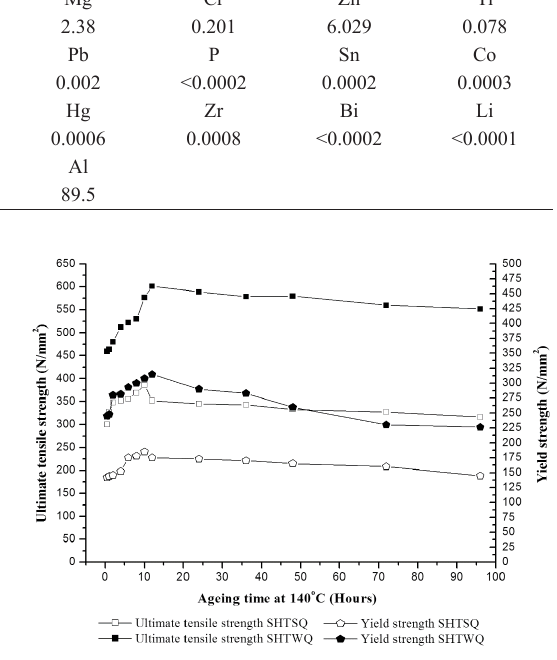
Figure 2. The relationship between ageing time and UTS and yield strength for SHTWQ and SHTSQ & 8% pre-strained test samples aged at 140 °C.